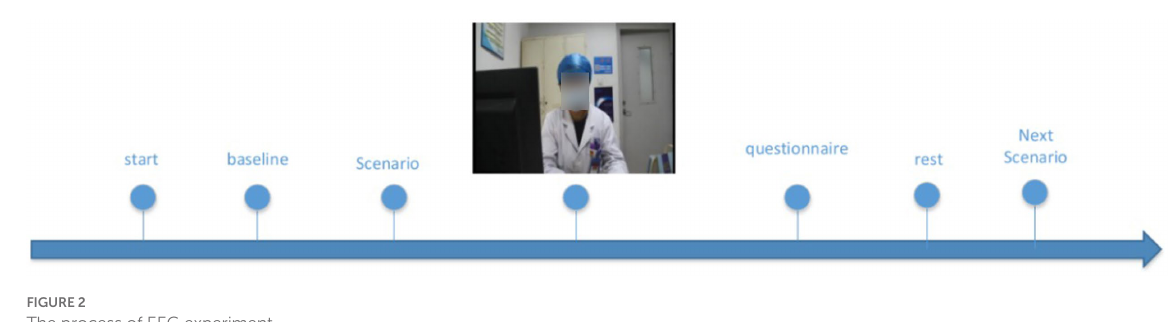
FIGURE 2 The process of EEG